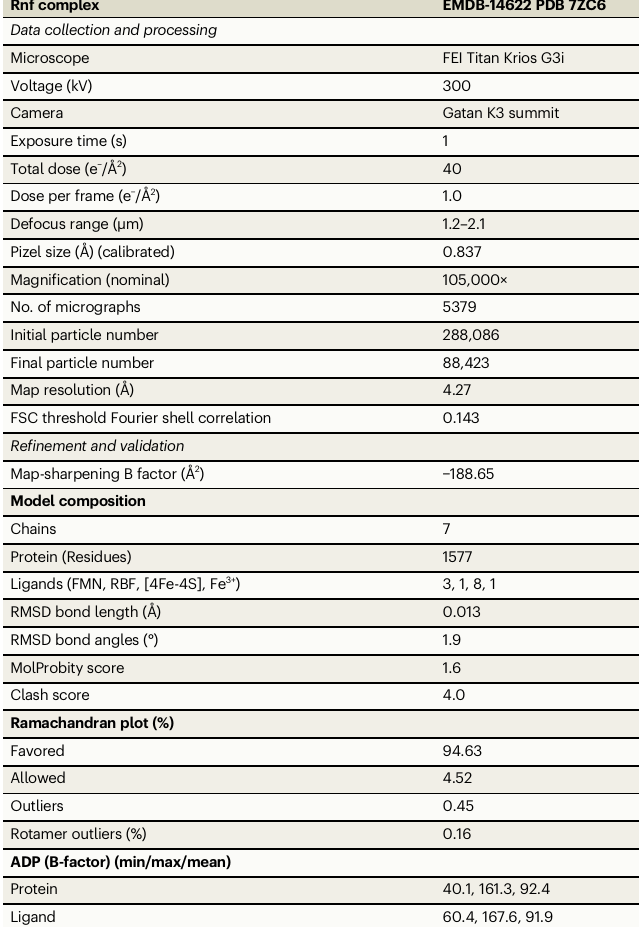
Table 1 | Cryo-EM data collection, re fi nement, and